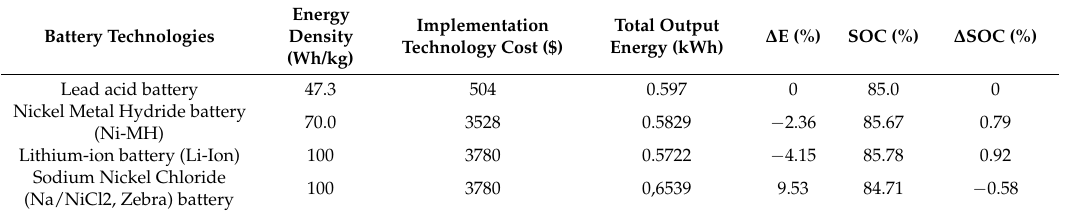
Table 8. Comparisons between different battery technologies applied to the simulation of golf car.